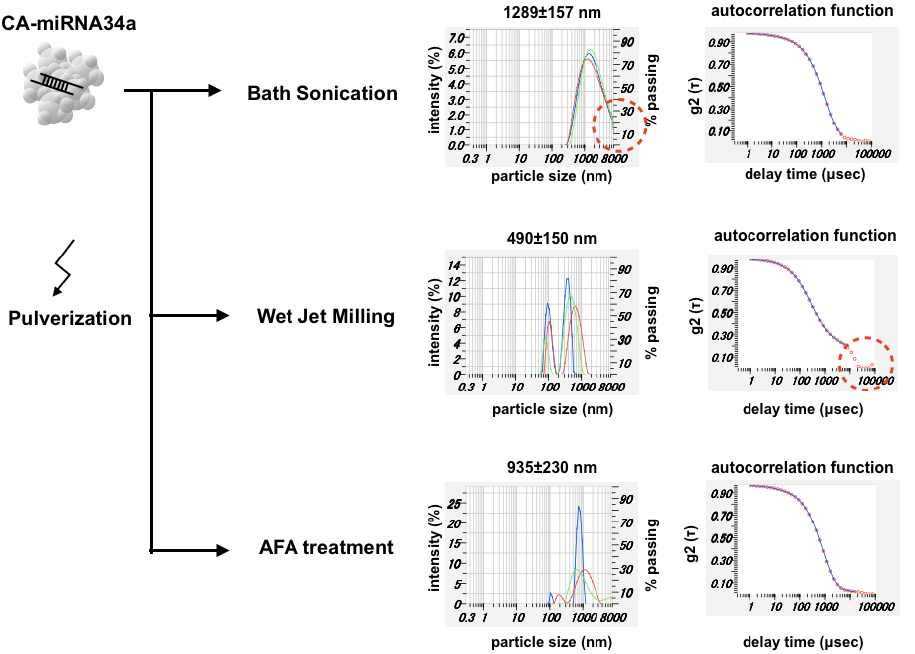
Figure 2. Pulverization of sCA-miRNA34a. The high-concentration sCA-miRNA34a solution for intravenous injection was analyzed by DLS. Three kinds of pulverization, bath sonication (38 kHz), wet jet-milling (30 pass), and adaptive focused acoustics (AFA) treatment (1 MHz), were performed to reduce the sCA-miRNA34a microparticles. Both particle size distribution and autocorrelation function are shown for each